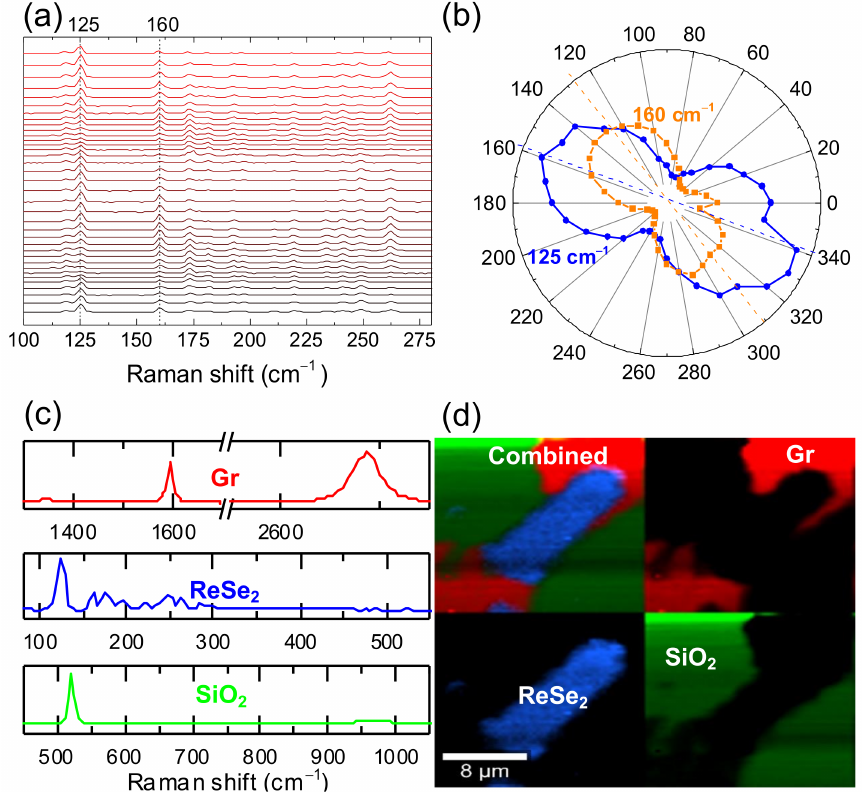
Figure 4. ( a ) Incident light polarization-dependent Raman spectra, obtained by rotating the sample from 0 ◦ to 360 ◦ (with a step of 10 ◦ ) and the initial angle being arbitrary to the sample crystallographic axis. The peaks at 125 cm − 1 and 160 cm − 1 are strongly related to the rotation sample angles. ( b ) A plot of intensities of the two modes (125 cm − 1 mode in dark blue and 160 cm − 1 mode in orange). ( c ) Raman spectra representative of ReSe 2 (blue line), graphene (red line) and SiO 2 (green line). ( d ) Color-coded Raman map of the device, combining SiO 2 (green), GSC (red), and ReSe 2 (blue) Raman spectra. The Raman spectra presented in ( a ) were used as a reference to obtain the Raman mapping